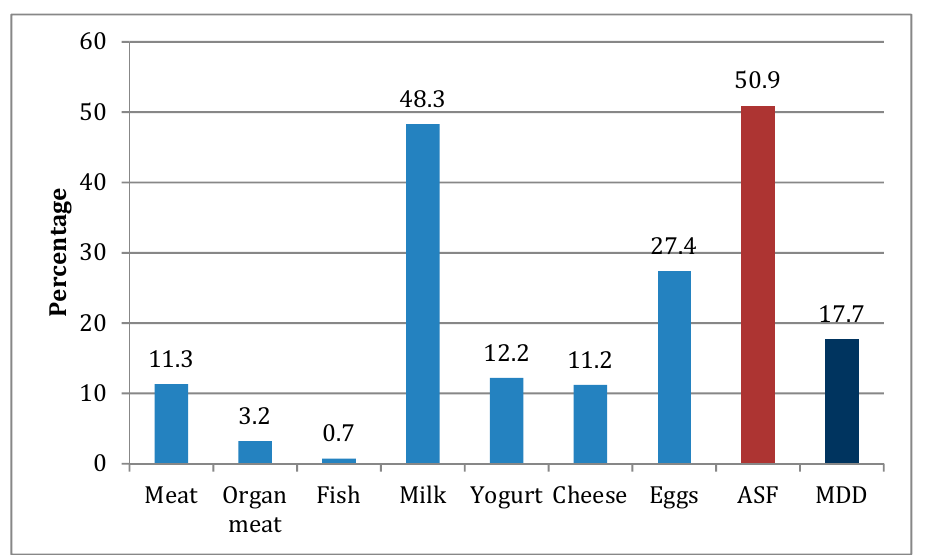
Figure 1. Proportion of sample 6–36-month-old children consuming animal source foods and meeting the minimum dietary diversity. ASF, animal source foods; MDD, minimum dietary